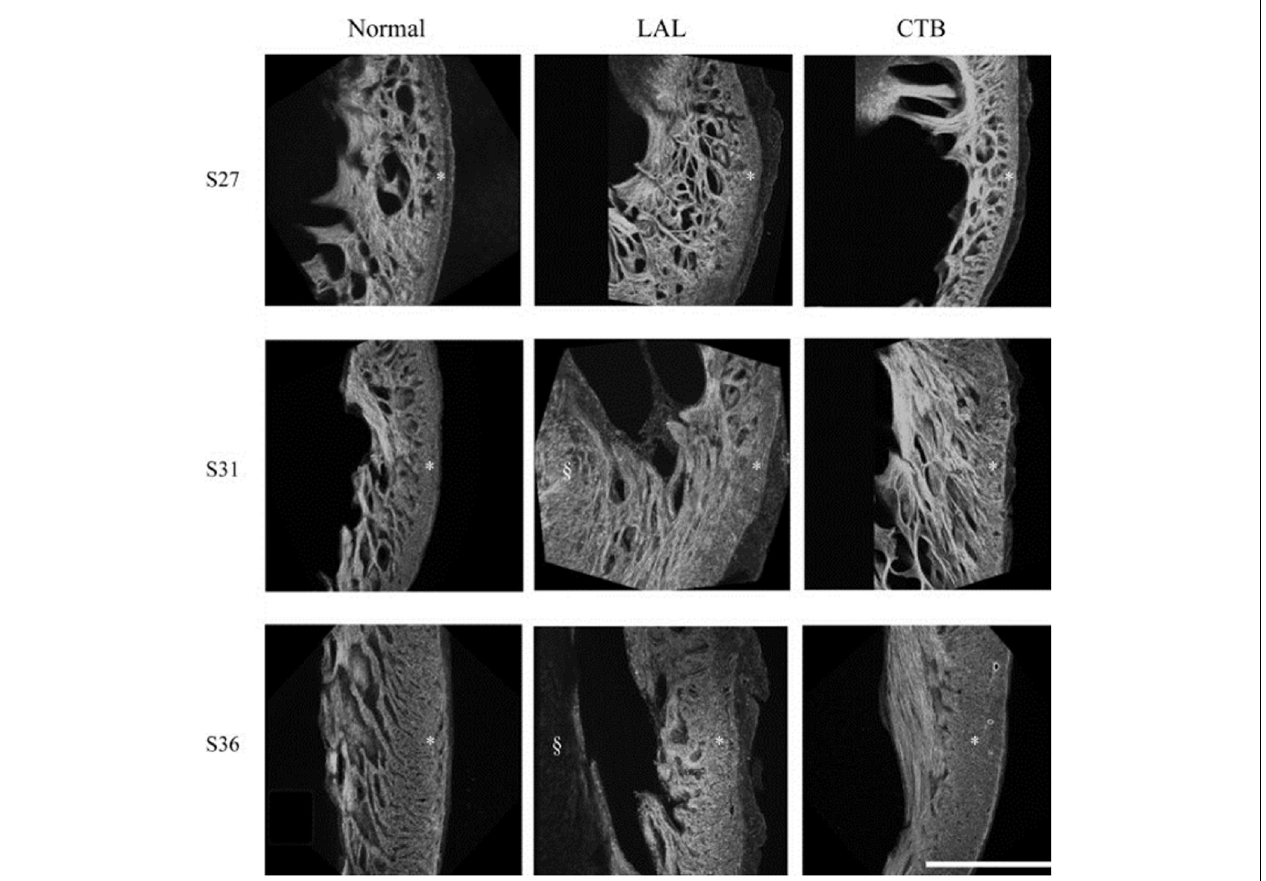
FIGURE 4 | Developmental change of the LV myocardium architecture in normal, LAL, and OTB embryos shown by 3D reconstructions of f-actin labeled myocardium. Asterisk, compact myocardium; section symbol,